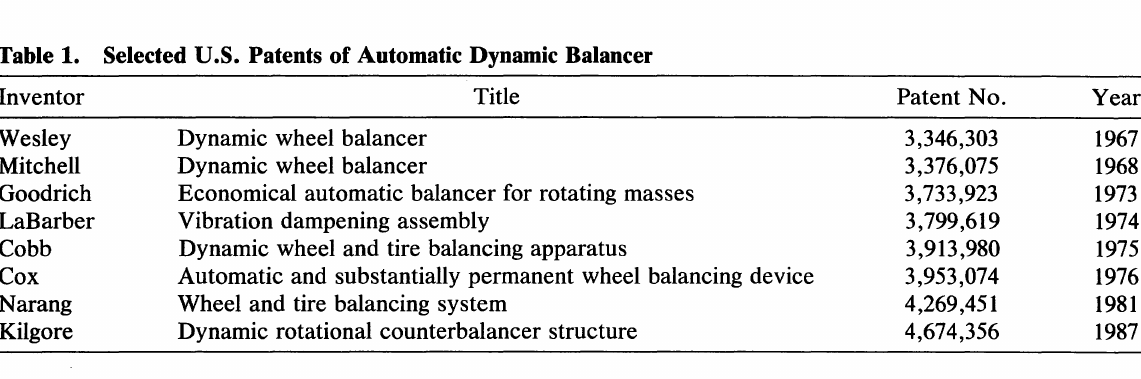
Table 1. Selected U.S. Patents of Automatic Dynamic Balancer